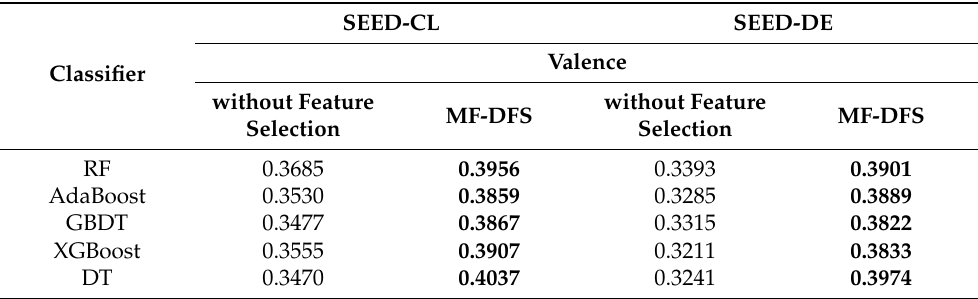
Table 9. Classification accuracy comparison across different machine learning methods in two different feature sets on the MAHNOB-HCI